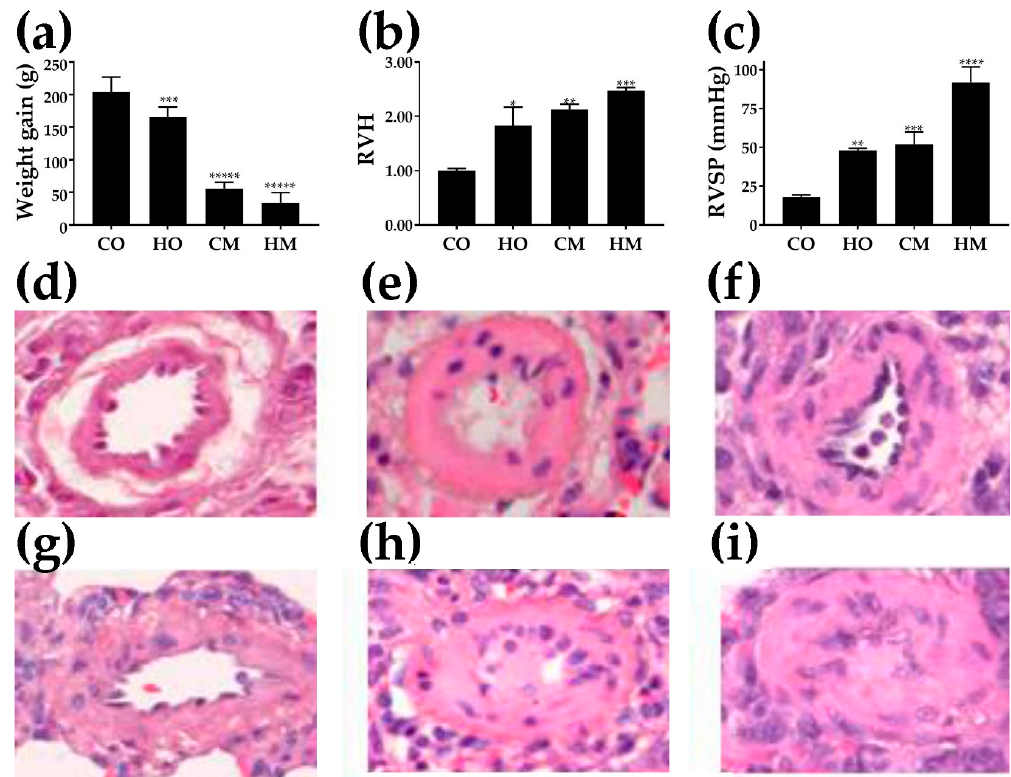
Figure 1. Effects of the pulmonary hypertension on ( a ) weight gain ( n = 8), ( b ) right-ventricle hypertrophy (RVH, dimensionless measure) ( n = 8), ( c ) right-ventricle systolic pressure (RVSP) ( n = 8), and ( d – i ) histology of the pulmonary arteries. Hematoxylin and eosin (H&E)-stained sections from lungs of rats from the groups: control (CO) ( d ), hypoxia (HO) ( e ), monocrotaline (CM) ( f ), and monocrotaline and hypoxia (HM) ( g , h , i ). Note in ( h ) and ( i ) that the pulmonary arteries exhibit luminal obstruction. Statistical significance ( t- test): * ( p < 0.05), ** ( p < 0.01), *** ( p < 0.005), **** ( p < 0.001), ***** ( p < 0.0001).